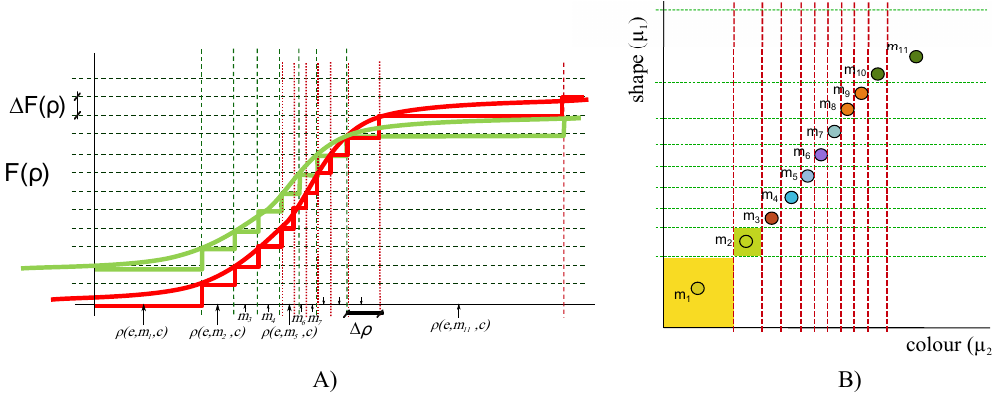
Figure 2. ( A ) Example of calibration curves for a VAS aimed to measure shape ( green ) and colour ( red ); ( B ) Measurement performed in F transformed to the object space M considering shape µ 1 and colour µ 2 . In this example, the colour of the objects m 10 and m 11 can be distinguishable but their shape